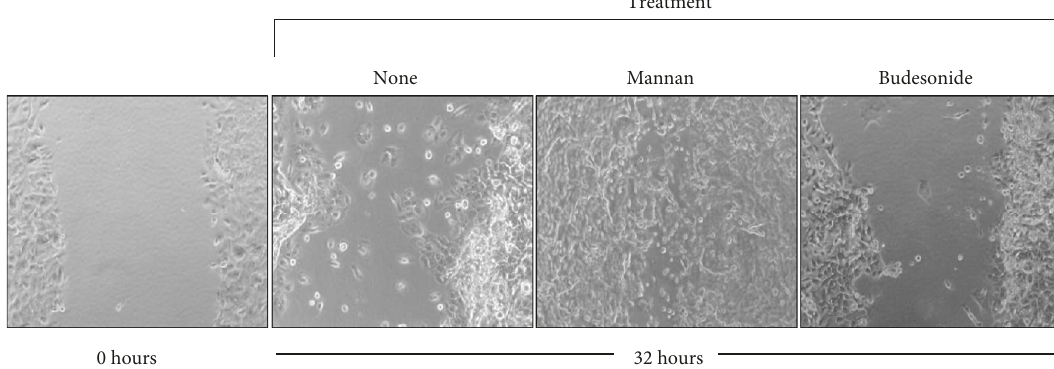
Figure 2: SC-MN facilitates wound closure in NHBEC. Mechanically injured NHBEC were treated with saline (none), SC-MN (1 mg/ml), or budesonide (10 − 7 M). Final magni fi cation: 50x.